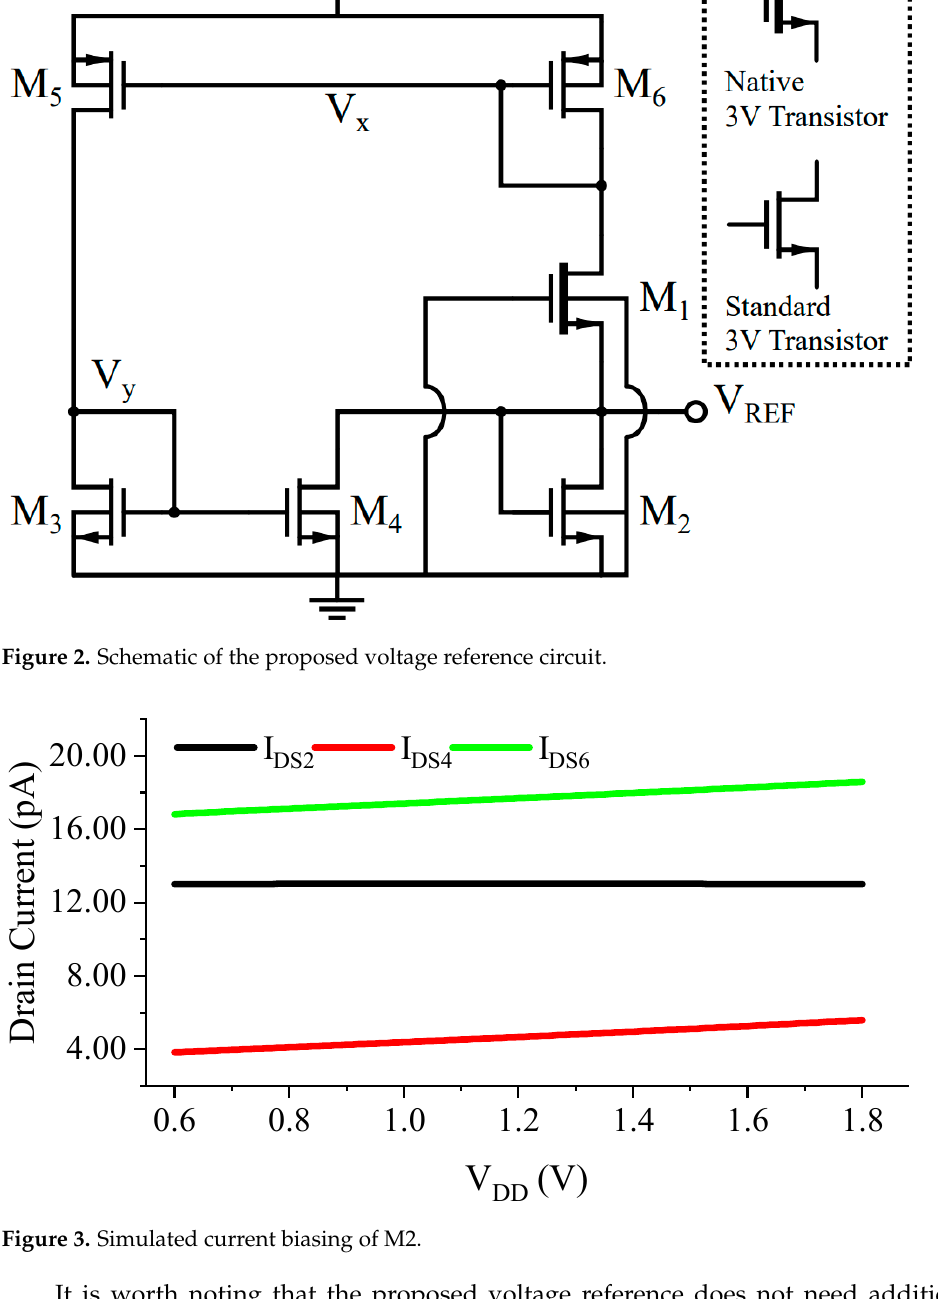
Figure 3. Simulated current biasing of M2.